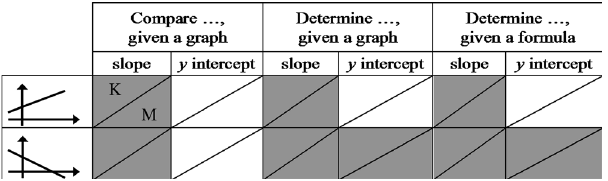
FIG. 1. Test structure: two signs for the slope (positive and negative); two concepts (slope and y intercept); three question types using two tasks (compare or determine) and two representations (graph and formula); two contexts [kinemat- ics (K), mathematics (M)]. The items marked in gray require an